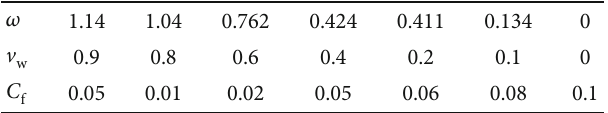
Table 2: The assumed deviation factor of water velocity response to pure water velocity and coal fi nes concentration.